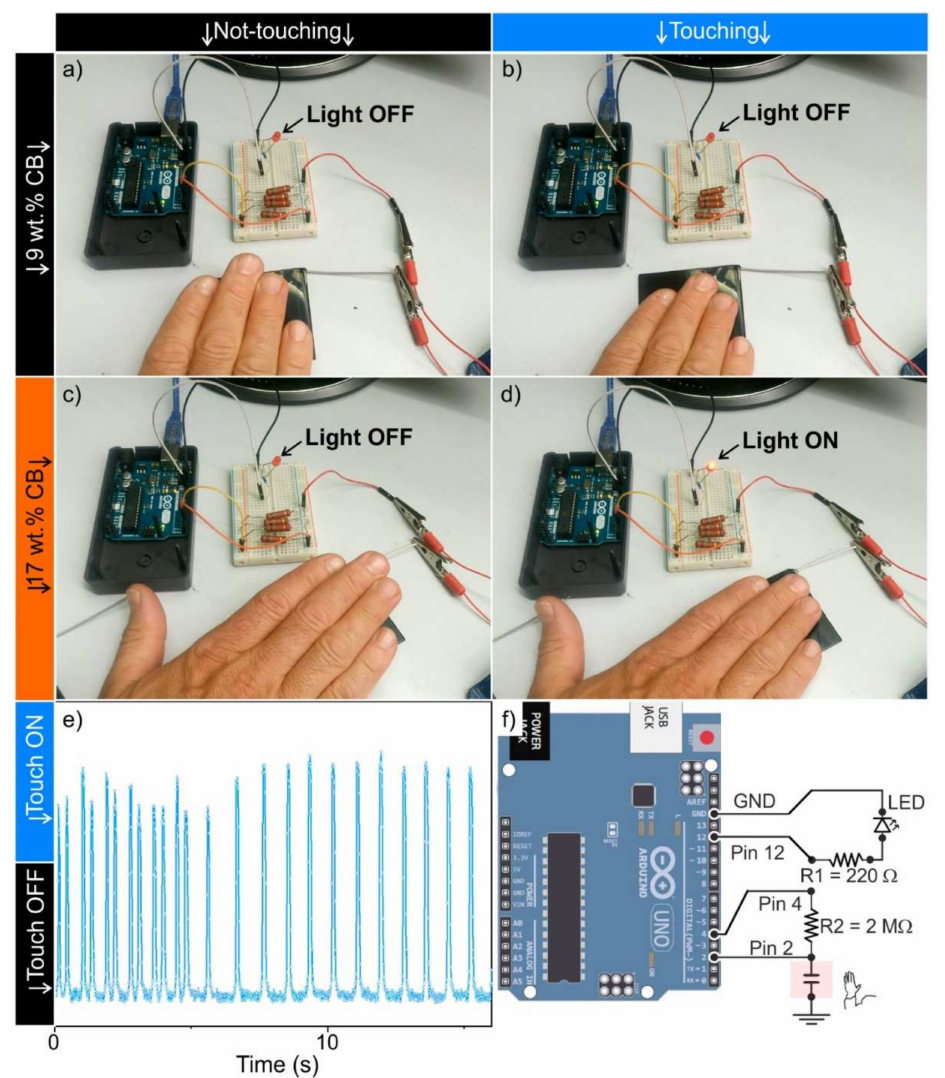
Figure 6. Proof of concept of the melt-compounded CB-filled PA66 specimens (50 × 50 × 2 mm in size) tested under not-touching/touching operations. Compounds containing: 9 ( a , b ) and 17 wt. % of CB ( c , d ) (i.e., below and over the percolation threshold, respectively); touch sensing output from the device under ON/OFF touching cycles for 17 wt. % of CB ( e ); representation scheme of the Arduino board integrated with the touch sensors (input) and the LED (output) ( f